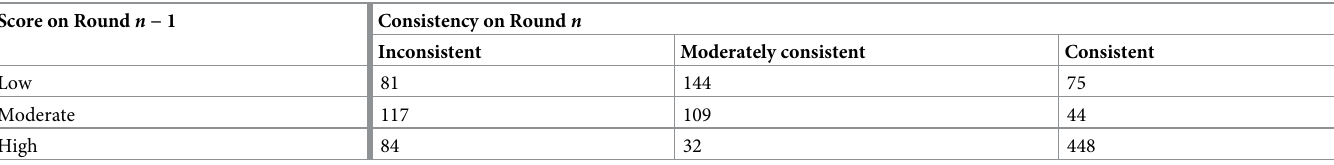
Table 1. Cross-frequencies of score on round n − 1 and consistency on round n